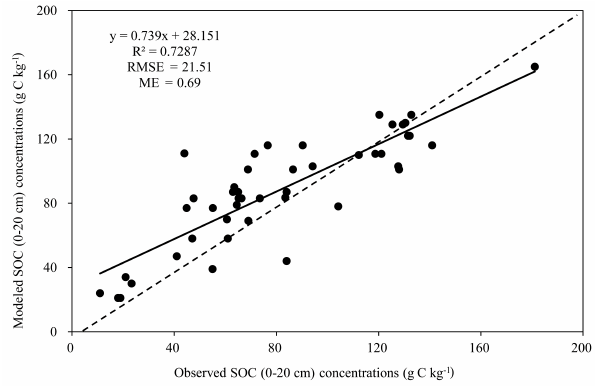
Figure 2. Comparison of the modeled and observed total biomass values.